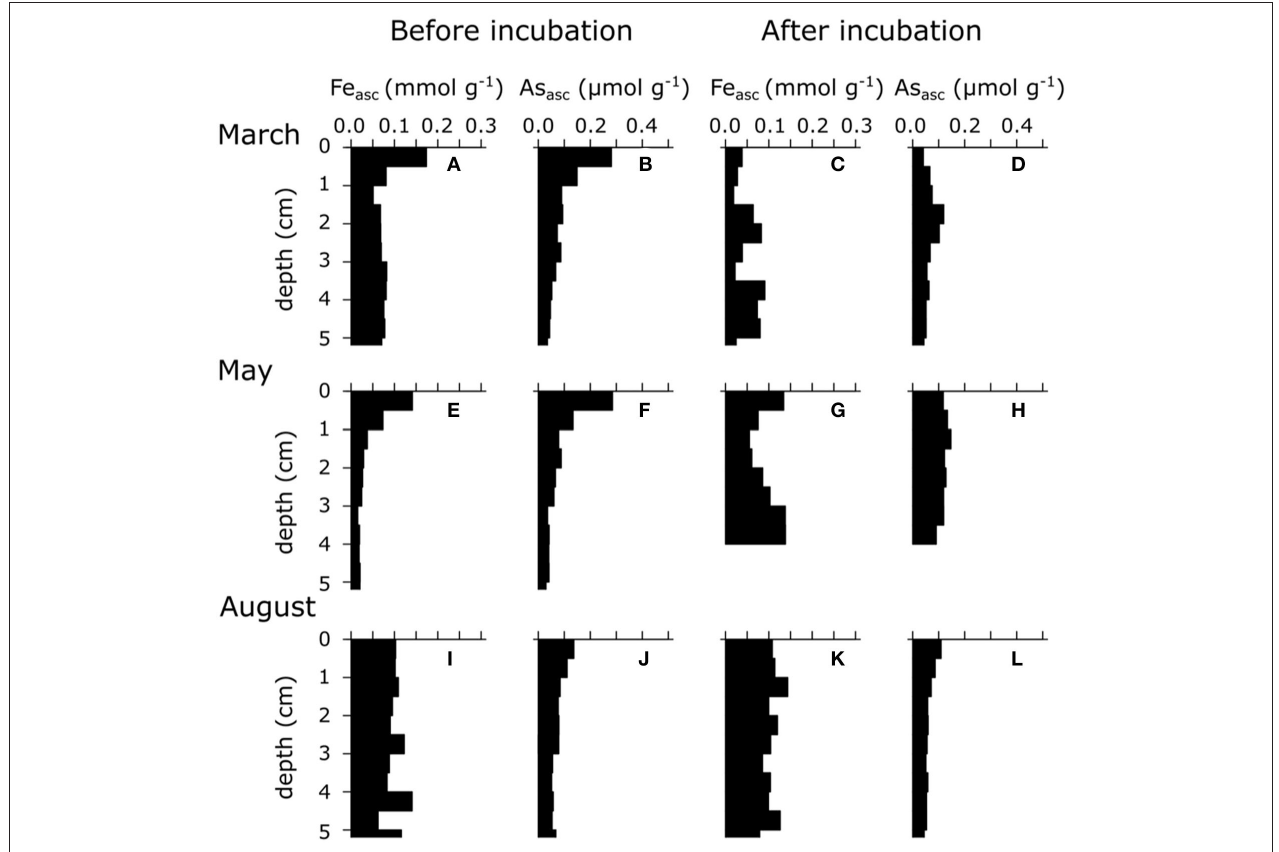
FIGURE 2 | Ascorbate extractable Fe (Fe asc ) and As (As asc ) of three different seasons (i.e., March, May, and August 2015) in the sediment of seasonally hypoxic Lake Grevelingen. (A,E,I) Solid-phase ascorbate extractable iron depth profile upon core retrieval. (B,F,J) Solid-phase ascorbate extractable arsenic depth profile upon core retrieval. (C,G,K) Solid-phase ascorbate extractable iron depth profile after prolonged anoxic incubation. (D,H,L) Solid-phase ascorbate extractable arsenic depth profile after prolonged anoxic incubation. Results are expressed in µ mol g − 1 dry weight. Note the difference in x-axis for Fe asc and As asc .